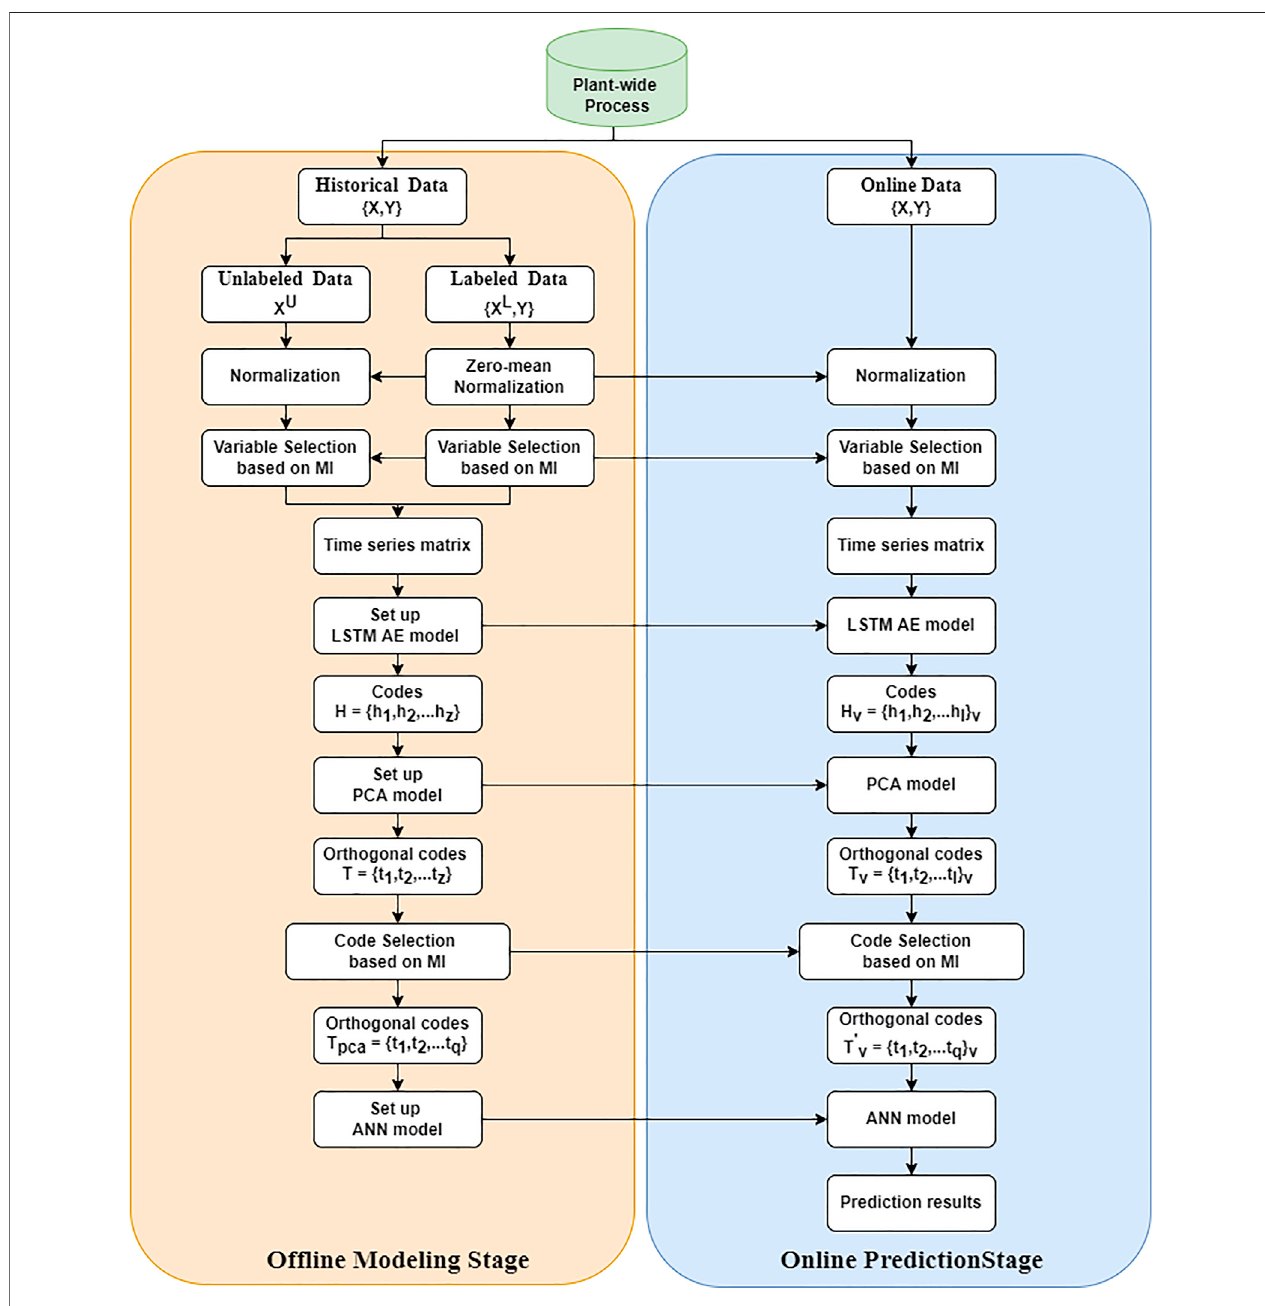
FIGURE 2 | Framework for the